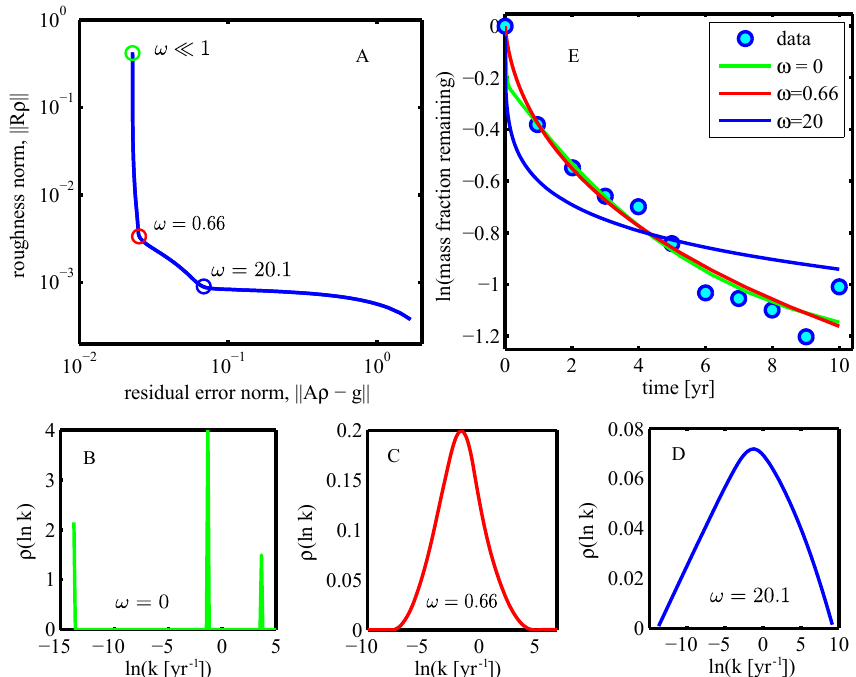
Fig. 3. Determining the optimal value of regularization parameter ω via the “L-curve” method (Hansen, 1994, 1987). Counterclockwise from the upper left: (A) The “L-curve”, k R ˆ ρ k vs. kˆ g − A ˆ ρ k . (B) The unregularized solution, similar to the solution found at the top of the curve, where the regularization parameter ω (cid:28) 1. (C) The solution associated with the corner of the curve corresponding to ω = 0 . 66. (D) The solution at the corner of the curve corresponding to ω = 20 . 1. (E) The data g(t) from the same LIDET dataset shown in Fig. 1a. The decay predicted from the solutions in B,C,D is also plotted. The corner with ω = 0 . 66 is chosen as the optimal solution since it predicts the data with significantly less residual error and has no trend in the residual, unlike the corner having ω = 20 . 1 The optimal solution is associated with a corner of the